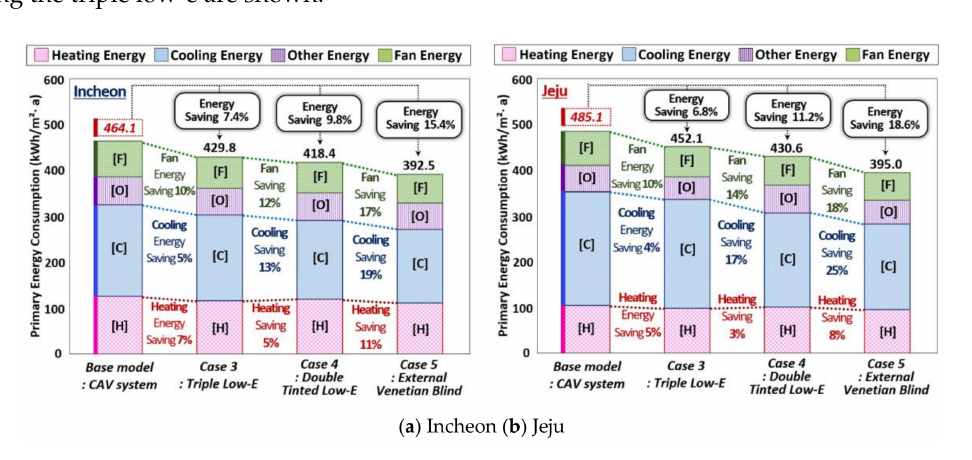
Figure 12. Primary energy consumptions and energy saving potential (%) of Case 3, Case 4, and Case